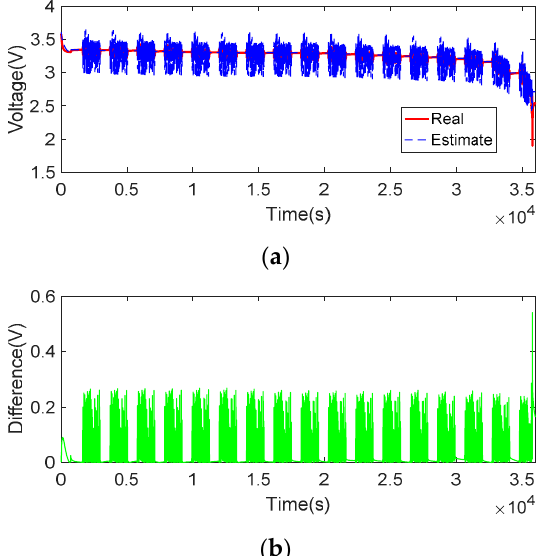
Figure 5. Comparisons between model output voltage and actual voltage. ( a ) Model output voltage and actual voltage; ( b ) Difference between model output voltage and actual voltage.